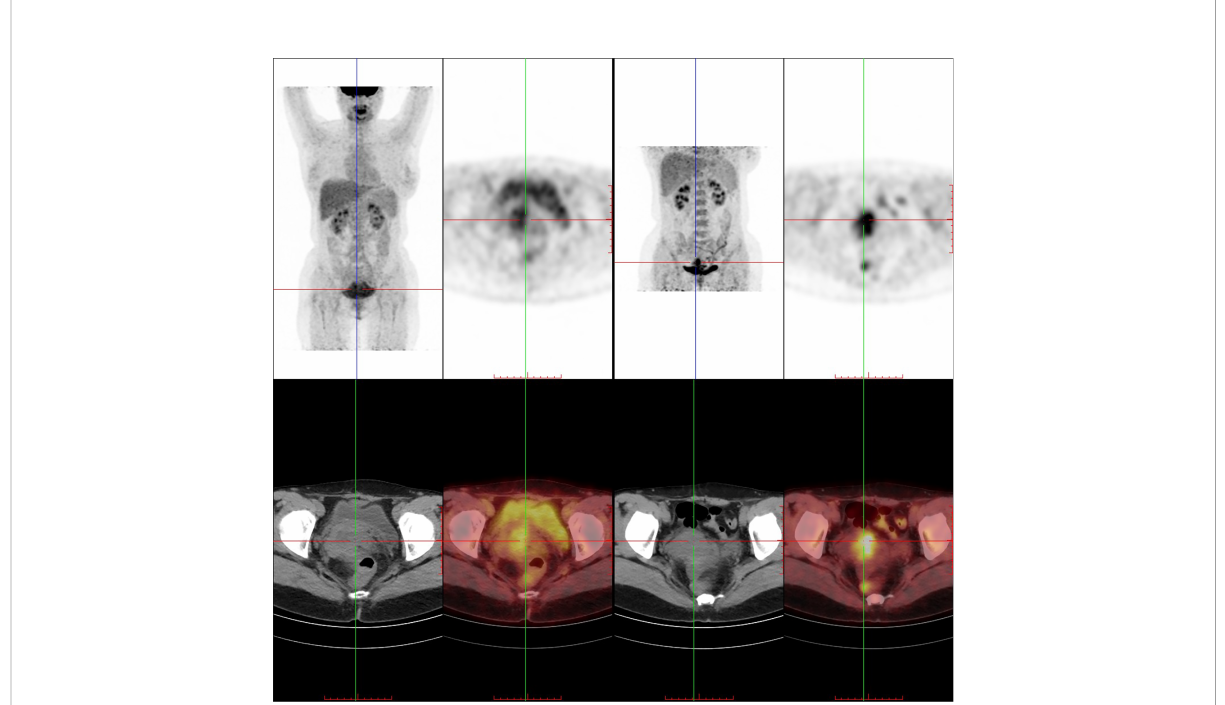
FIGURE 2 The cervix is widened with mass radioactive concentration foci, with a range of about 38 mm * 24 mm, SUVmax 4.0, delay 5.2. Radioactive concentration can be seen in the lower part of the uterine body, SUVmax 3.9, delay 5.6. Uterine